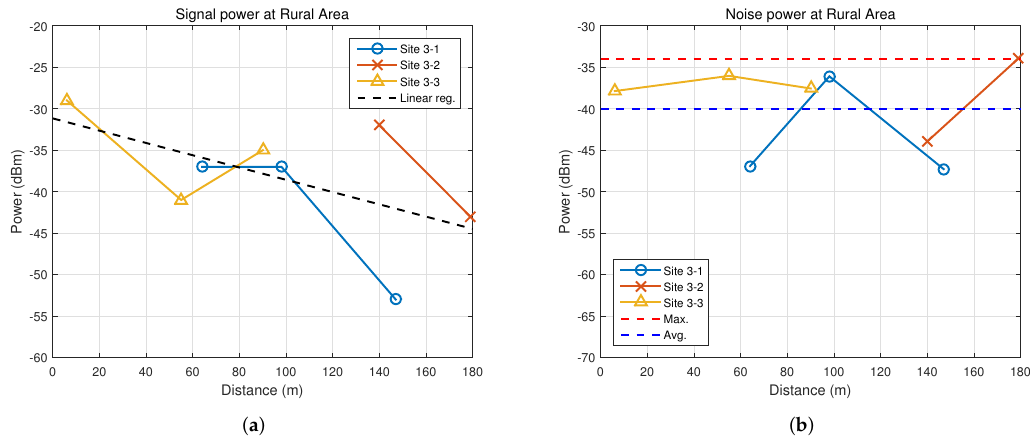
Figure 22. Overhead Rural Area. ( a ) Received power. ( b ) Noise